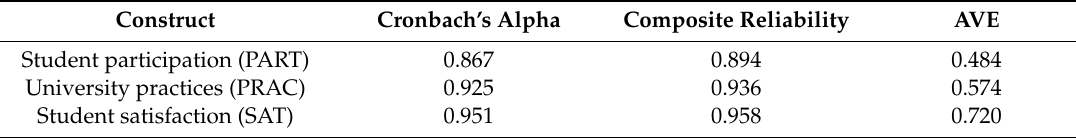
Table 6. Composite reliability and average extracted variance (AVE) of